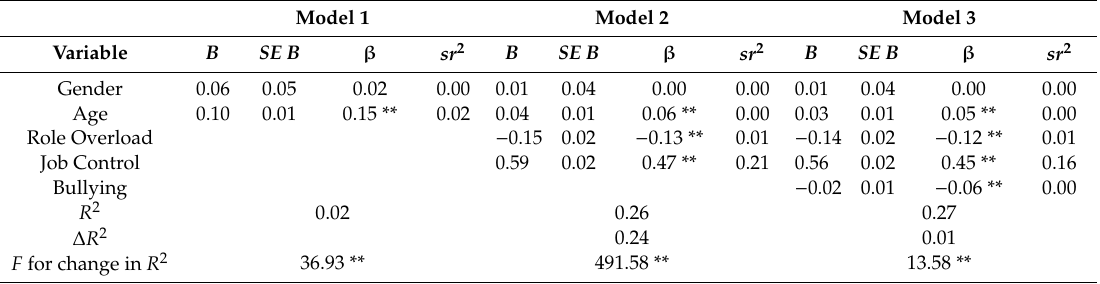
Table 4. Summary of hierarchical regression analysis for variables predicting job satisfaction ( n =